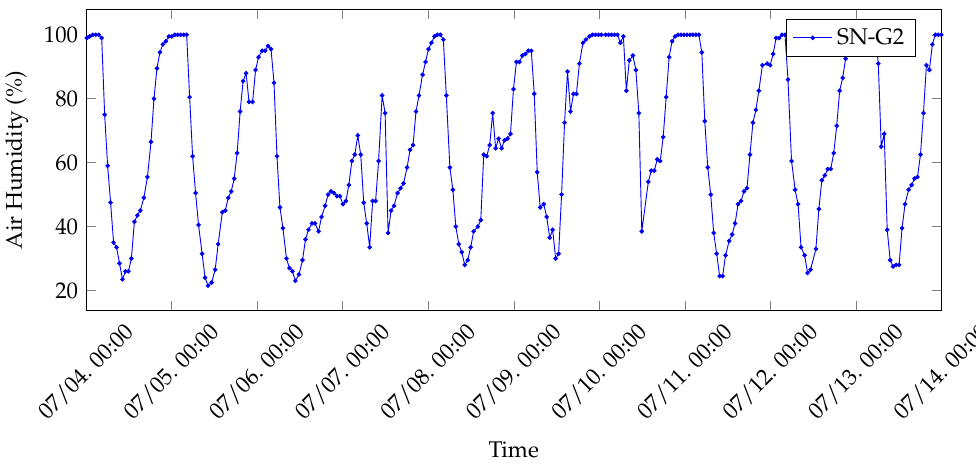
Figure 13. Air humidity related which has been collected in the greenhouse during ten days of test (by the SN-G2 node).